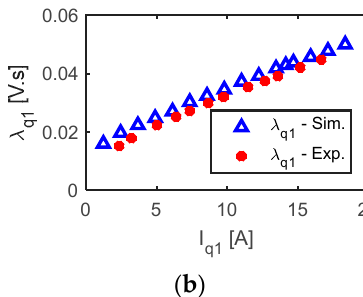
(cid:16) (cid:17) 0, i q1 at different currents and